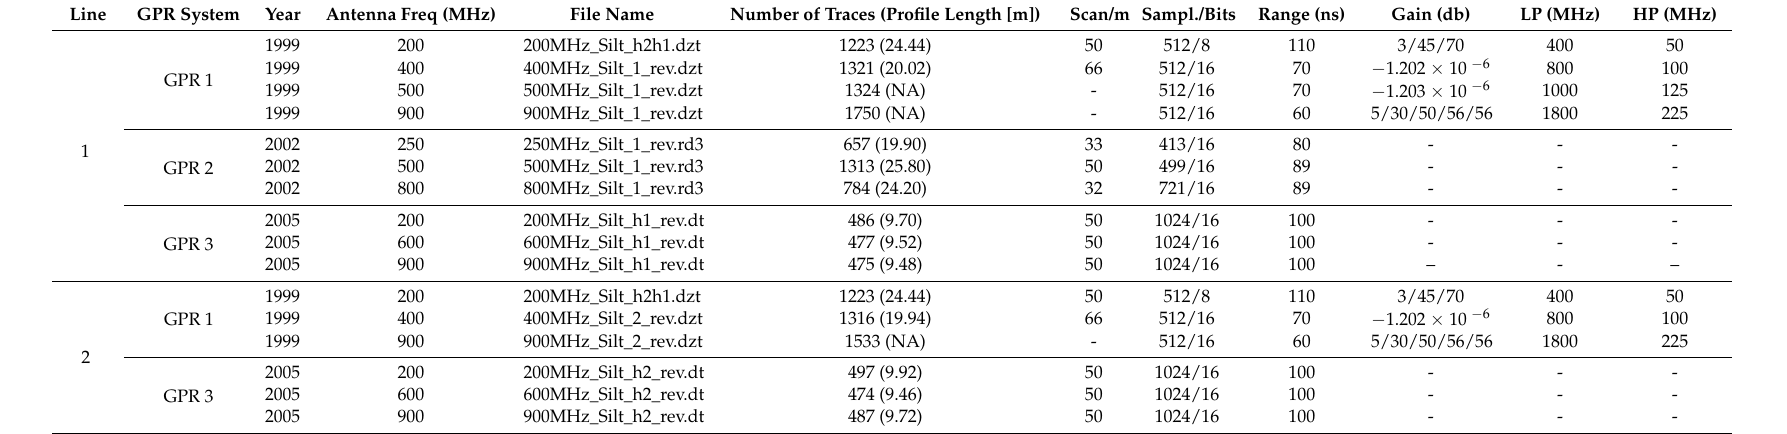
Table 3. Information about data collected in the silt region. NA means not available.